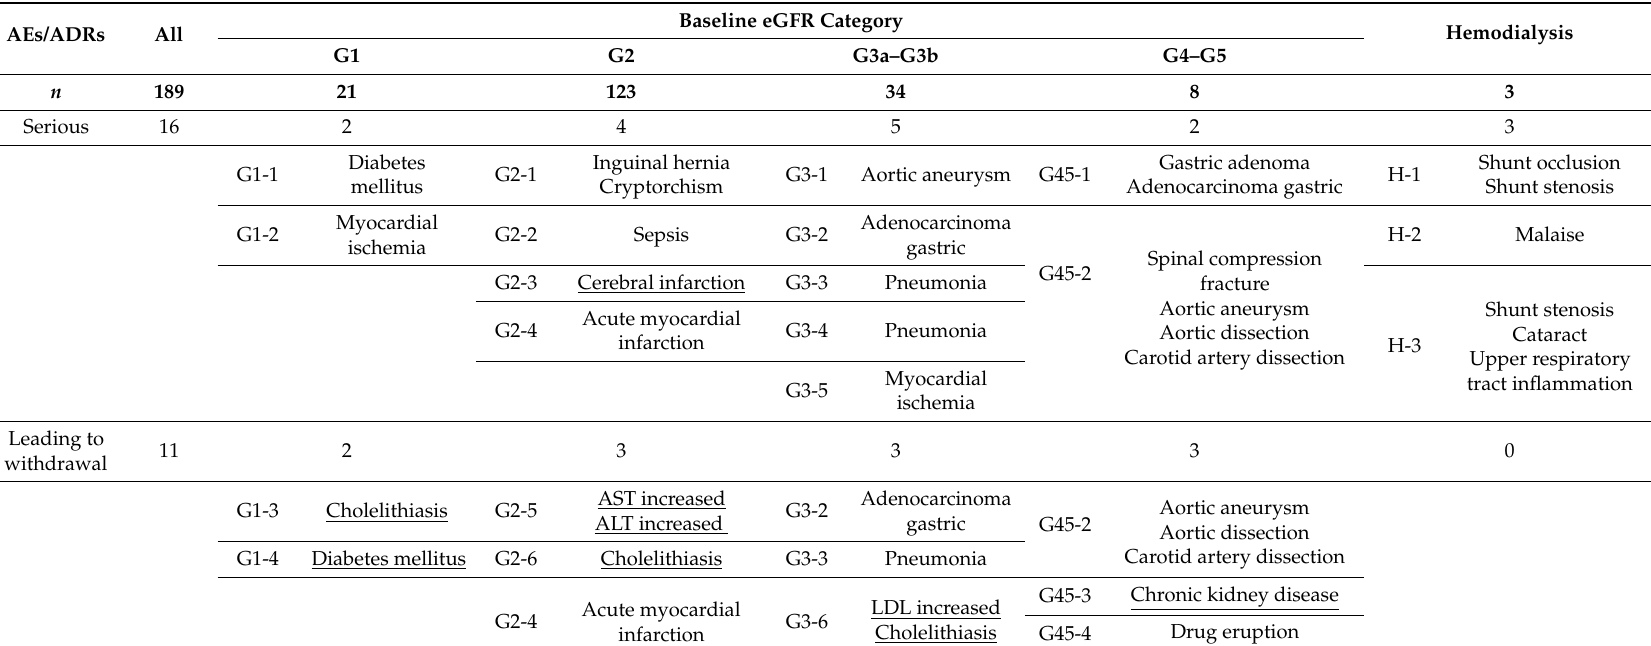
Table 5. Preferred terms of AEs (underlined events are